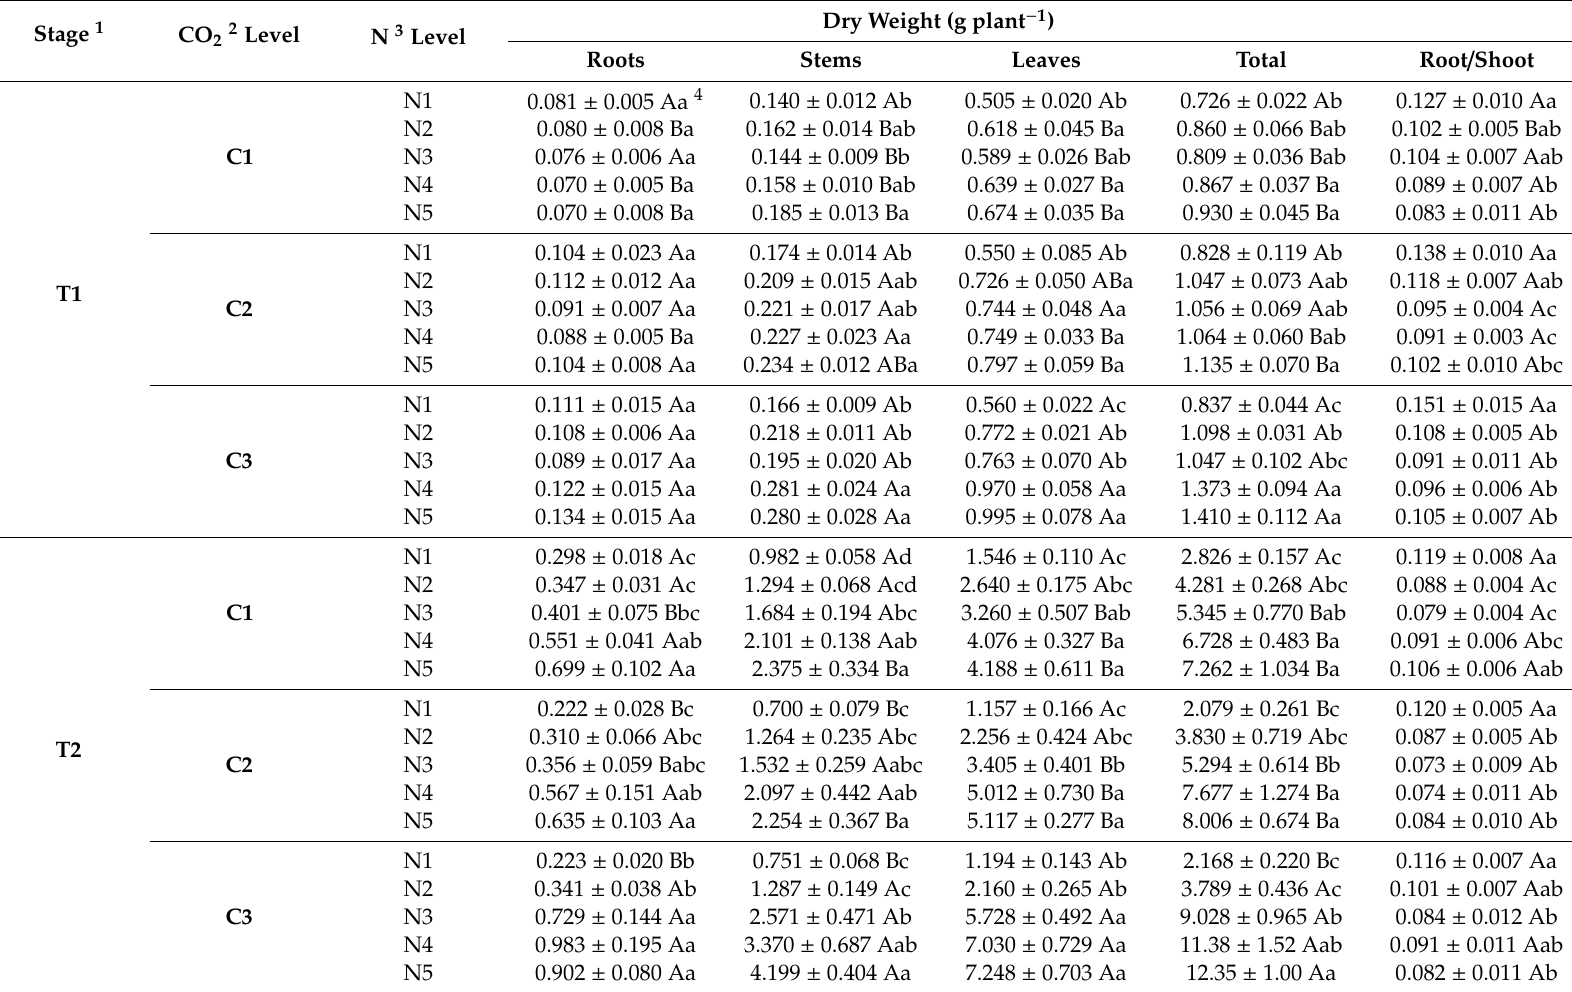
Table 2. The dry weight of roots, stems, leaves, whole plants and root / shoot ratios of cucumber grown under di ff erent [CO 2 ] and N levels at the seedling and initial fruiting stages ( n =